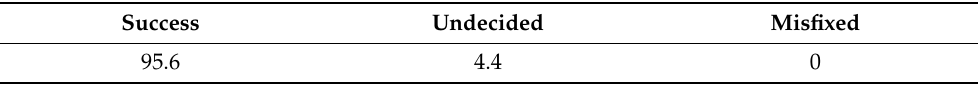
Figure 13. ZPD difference between BAUT and LEIJ. Figure 14. Daily maximum ZPD difference of the two baselines on selected days. Figures 15–17 show the performance of the extra ‐ wide ‐ lane ambiguity resolution for GPS, Galileo and BeiDou. Note that, since BeiDou carrier ‐ phase type L7I is not available, only the extra ‐ wide ‐ lane ambiguity resolution of C56 and C12 is assessed. From these three figures, we can see that the ambiguity fixing rate of extra ‐ wide lanes E57, E58, E78 and C12 can all reach 100%, and the fixing rate of G25 and E68 can reach more than 99%. Although the performance of C56 is the worst, it can also reach more than 96%. M a x i m u m Z P D d i ff e r en c e ( mm ) F i x i ng r a t e o f E W a m b i gu i t y ( % )